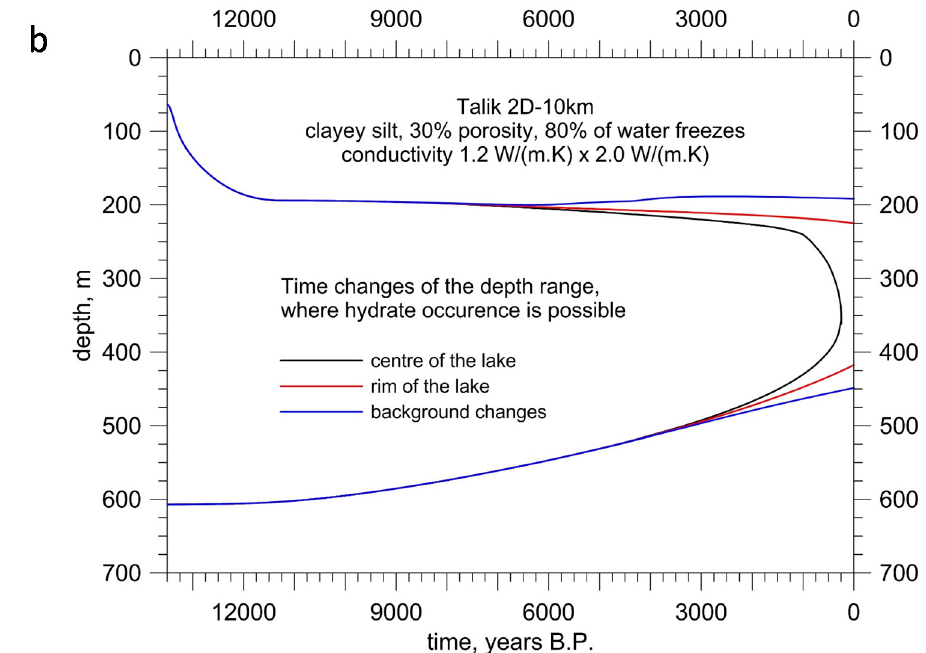
Figure A4. Variation of the permafrost ( a ) and GH ( b ) stability boundaries for a large lake, with a width of 10 km, like Parsons